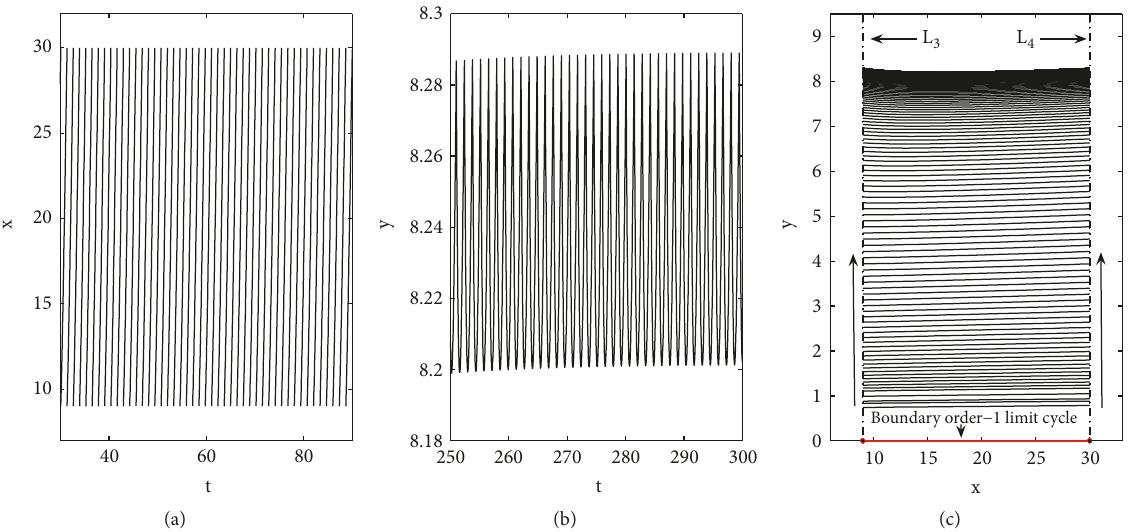
Figure 2: (a–c) The boundary order-1 limit cycle (𝑥 𝑇 (𝑡),0) is unstable and an order-1 limit cycle is generated. The red line represents the boundary order-1 limit cycle. The parameters are fixed as 𝑟 = 1.5 , 𝐾 = 50 , 𝑚 = 0.15 , 𝐴 = 0.5 , 𝑠 = 0.05 , ℎ = 0.5 , 𝐸𝑇 = 30 , 𝛿 = 0.7 , 𝛿 = 0 , and 𝜎 = 0